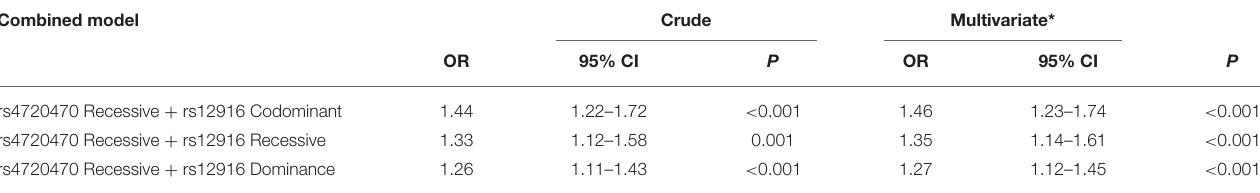
TABLE 5 | Univariate and multivariate adjusted logistic regression analysis of combined SNPs of NPC1L1 and HMGCR and the risk of PTVD. Combined model Crude